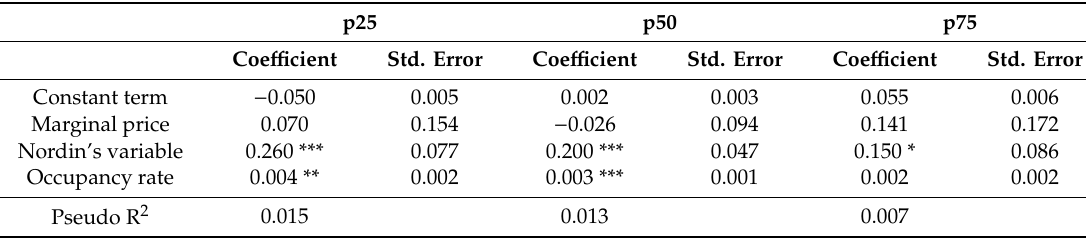
Table 8. Quantile regressions